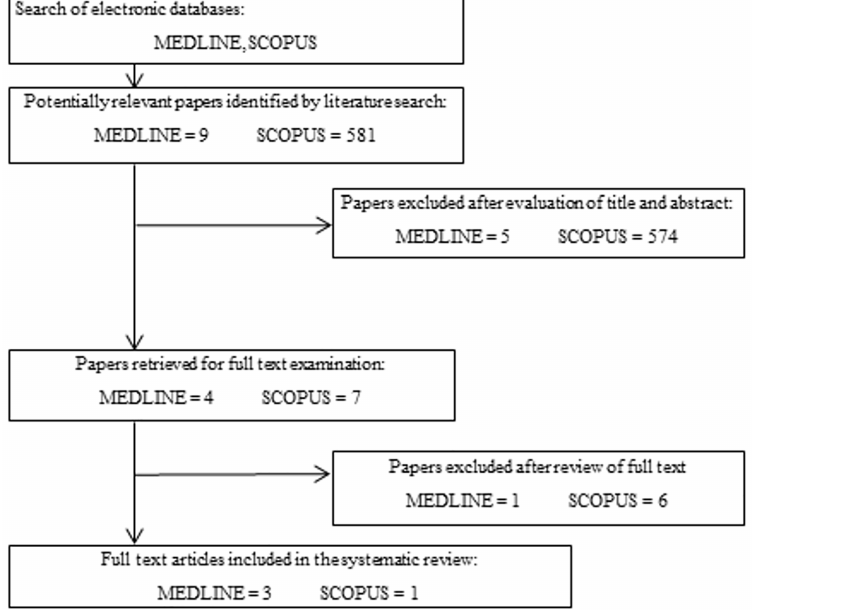
Fig 1. Flow chart shows the process of article selection in this